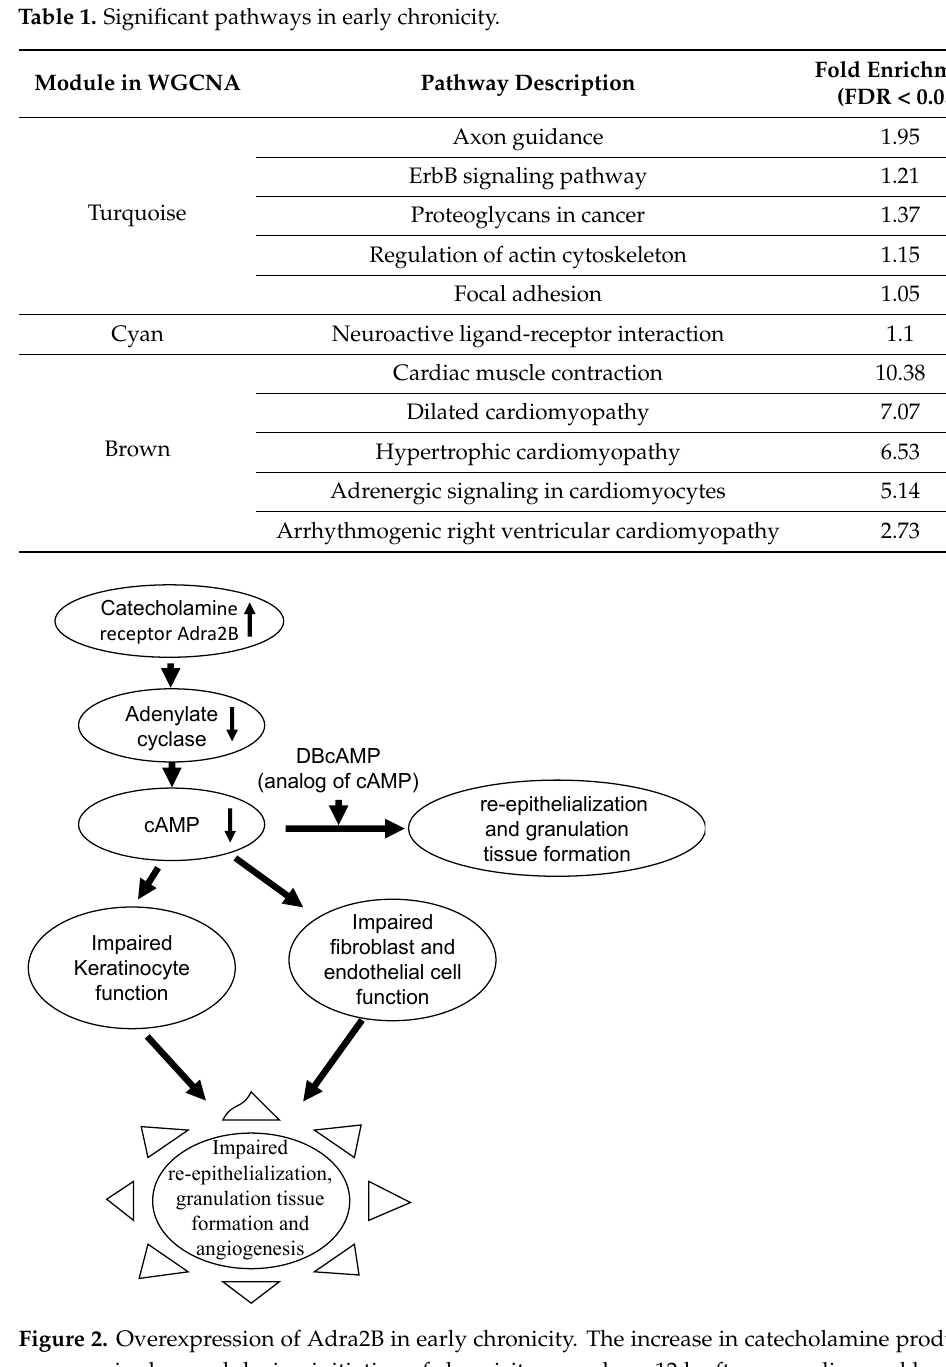
Figure 2. Overexpression of Adra2B in early chronicity. The increase in catecholamine producing enzymes is observed during initiation of chronicity as early as 12 h after wounding and has been reported in Basu et al., 2021. During progression Adra2B, a receptor of catecholamines, is also overexpressed. This leads to downregulation of adenylate cyclase and consequently of production of cAMP, a second messenger crucial for keratinocyte proliferation and migration, fibroblast function and angiogenesis. This contributes to lack of re-epithelialization in chronic wounds.